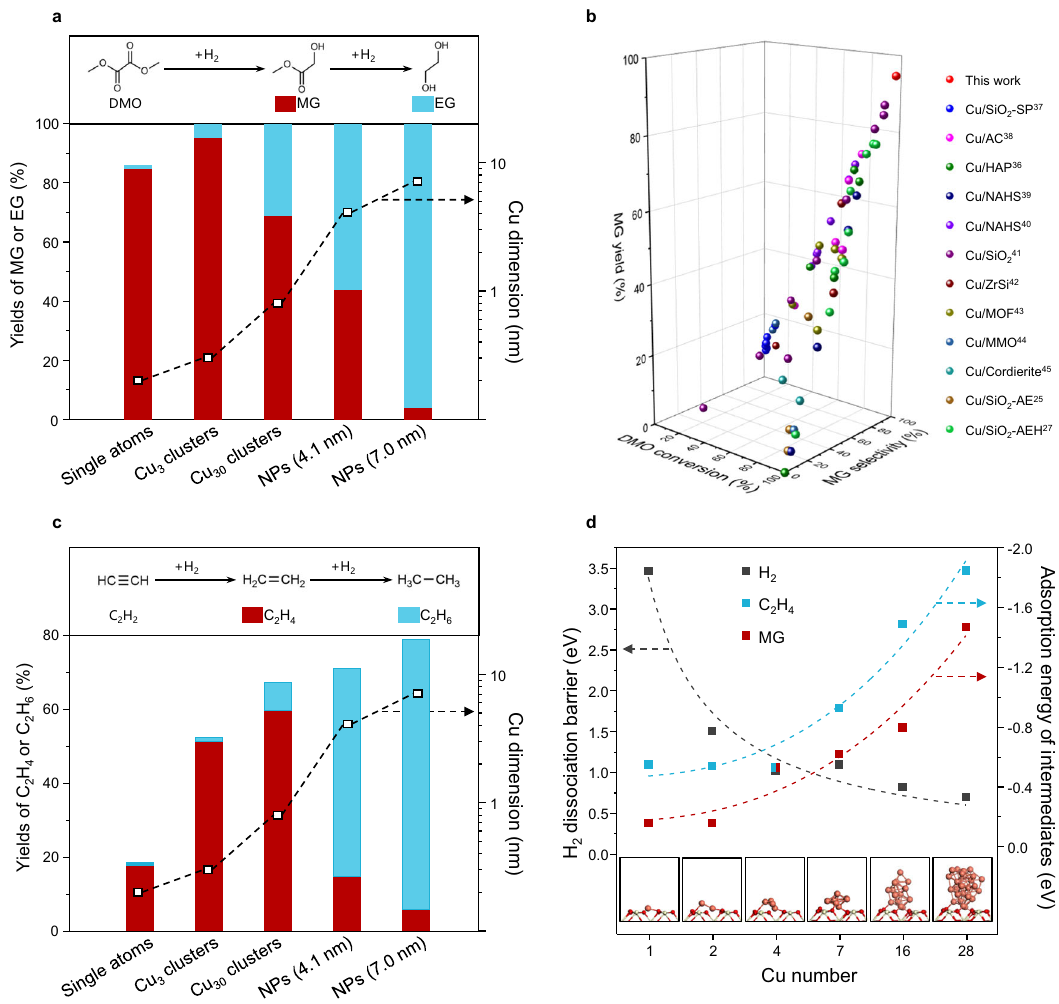
Fig. 5 | Regulating the selectivity of hydrogenation by controlling the dimen- sion of Cu species at atomic scale. a Catalytic performance of Cu species with different domain sizes for DMO hydrogenation. Reaction conditions: 200°C, 2.5MPa, H 2 /DMO=80, fl ow rate of6 g DMO /(g Cu ·h) normalized based on amount of exposed Cu weight. b Summary of DMO conversion, MG selectivity, and MG yield obtainedoverCu-basedcatalystsinliteratures,includingCu/SiO 2 -SP 36 ,Cu/AC 51 ,Cu/ HAP 35 , Cu/NAHS 52,53 , Cu/SiO 2 39 , Cu/ZrSi 54 , Cu/MOF 55 , Cu/MMO 56 , Cu/Cordierite 57 ,